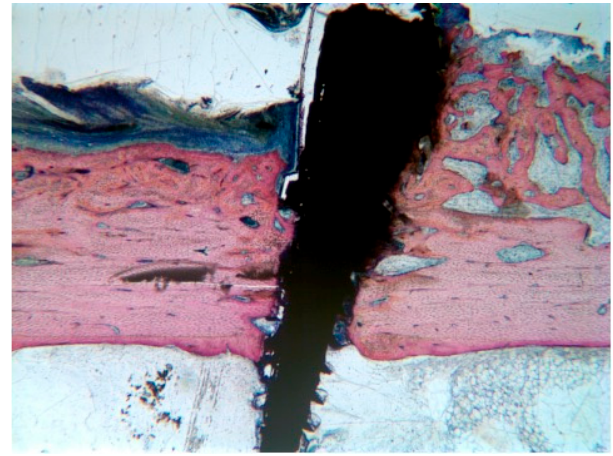
Figure 5. New bone appositions under the periosteum, around the pin holding the surgical guide. These bone formations were more likely found close to the surgically created defects. Here, the bleeding had formed a large blood clot supporting the periosteum for a longer time period, providing the necessary scaffold for new bone growth. Stevenel’s blue/van Gieson’s picrofuchsin stained sample at ×2.5 magnification.